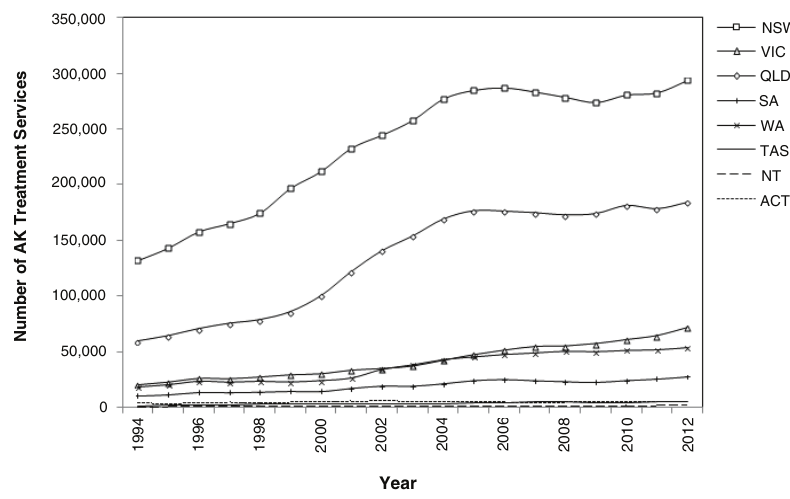
Figure 4. Total number of item 30192 services billed per year for each state from the period of 1994–2012.